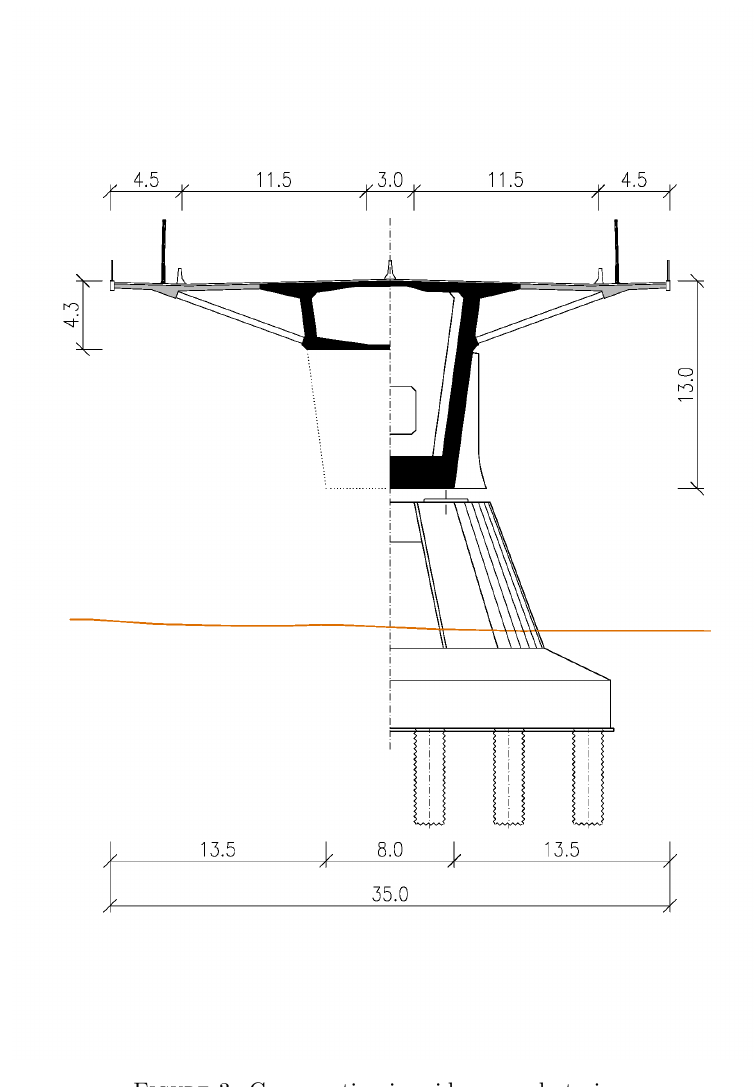
Figure 3. Cross-section in midspan and at piers.